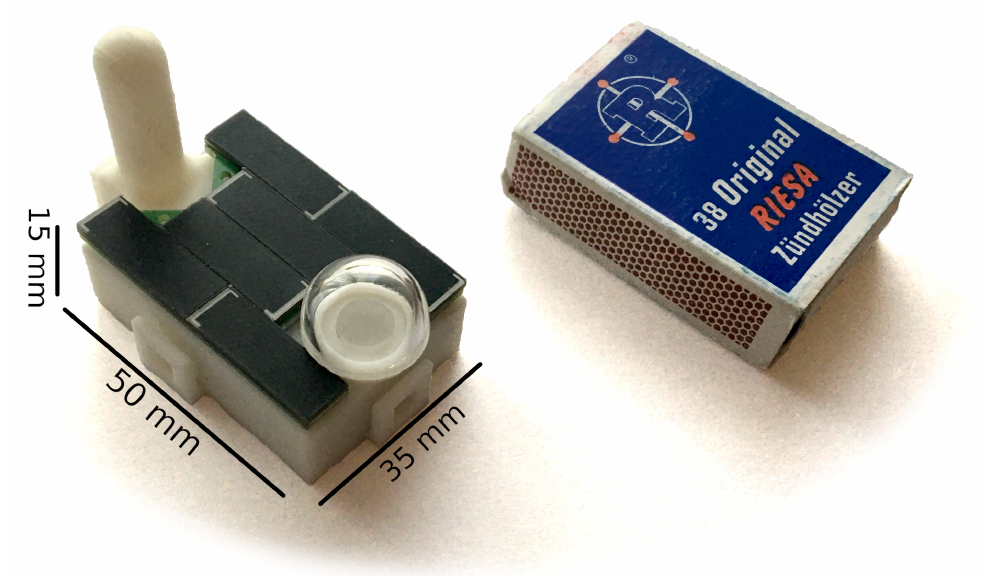
Figure 3. Sensor node prototype with embedded AS7341 and circuitry, in comparison to a standard matchbox as a dimension reference. On top are six solar cells, the glass dome over sensor and the